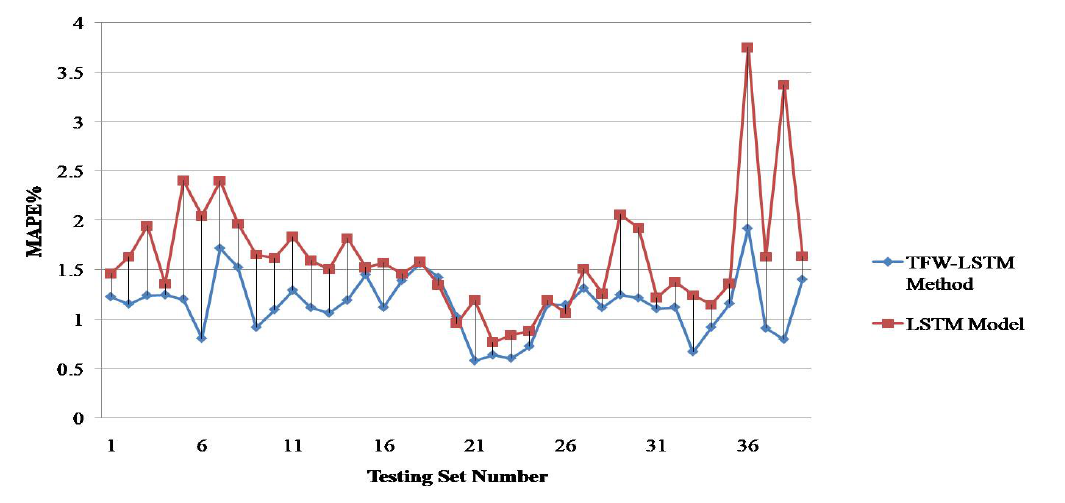
Figure 7. The mean absolute percentage error (MAPE%) comparison of TFW-LSTM method and traditional LSTM model.